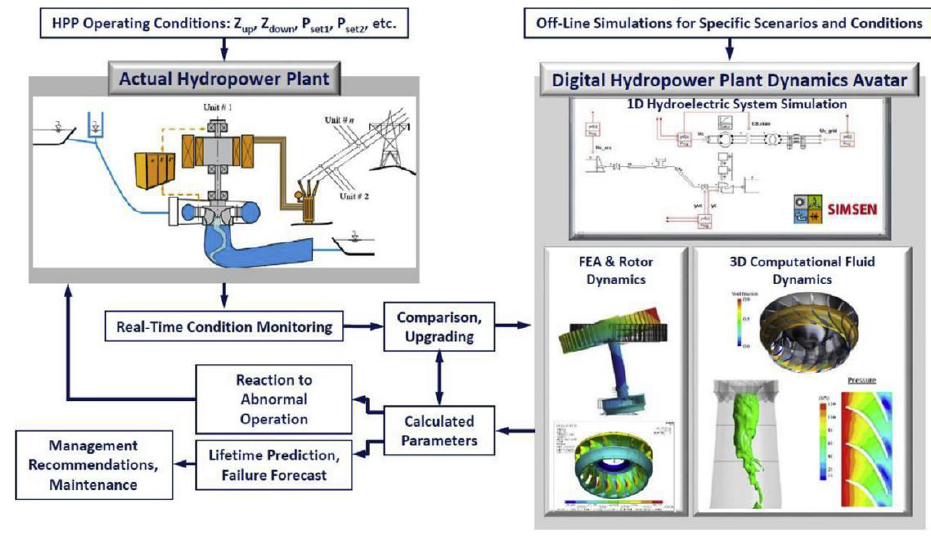
Figure 16. Concept of the Digital Avatar simulation method [106].